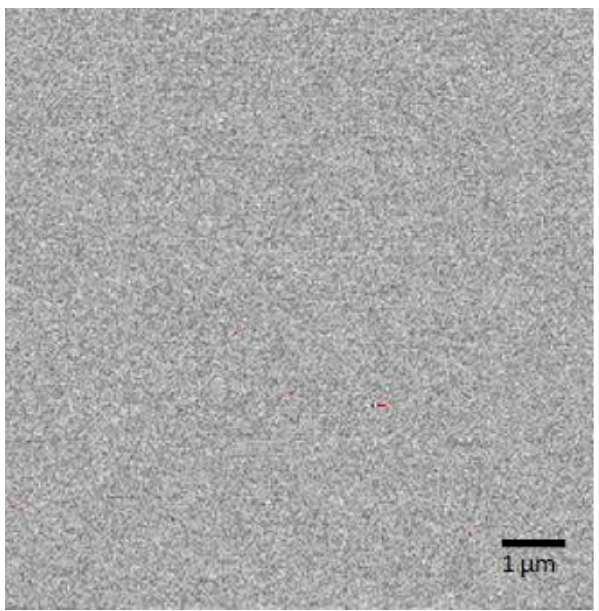
Figure 1. STM image of TiO 2 scaffolds.